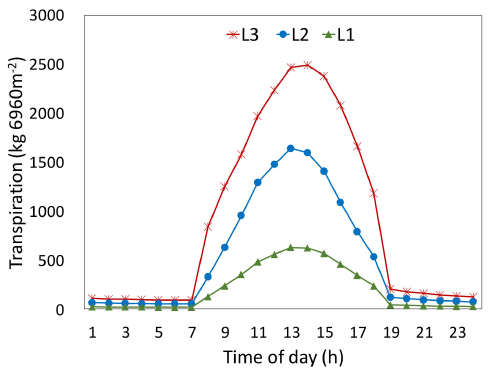
Figure 15. Calculated transpiration by the leaf area index (LAI). The amount of transpiration is obtained by multiplying the calculated transpiration per unit area by the greenhouse area, as shown. By dividing the transpiration by 90% and multiplying it by the area of the farm, the irrigation volume can be estimated